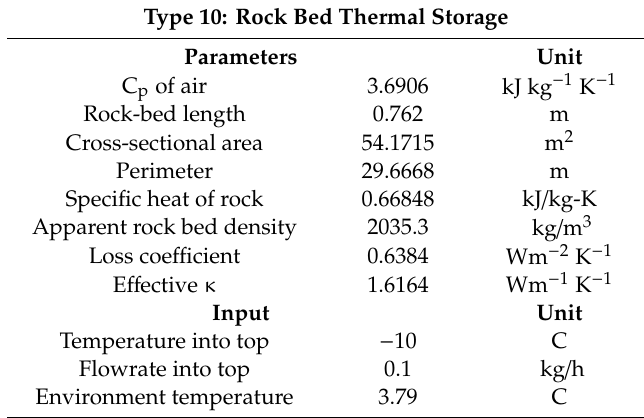
Table 2. Parameters and input variables of Type 10 rock-bed.